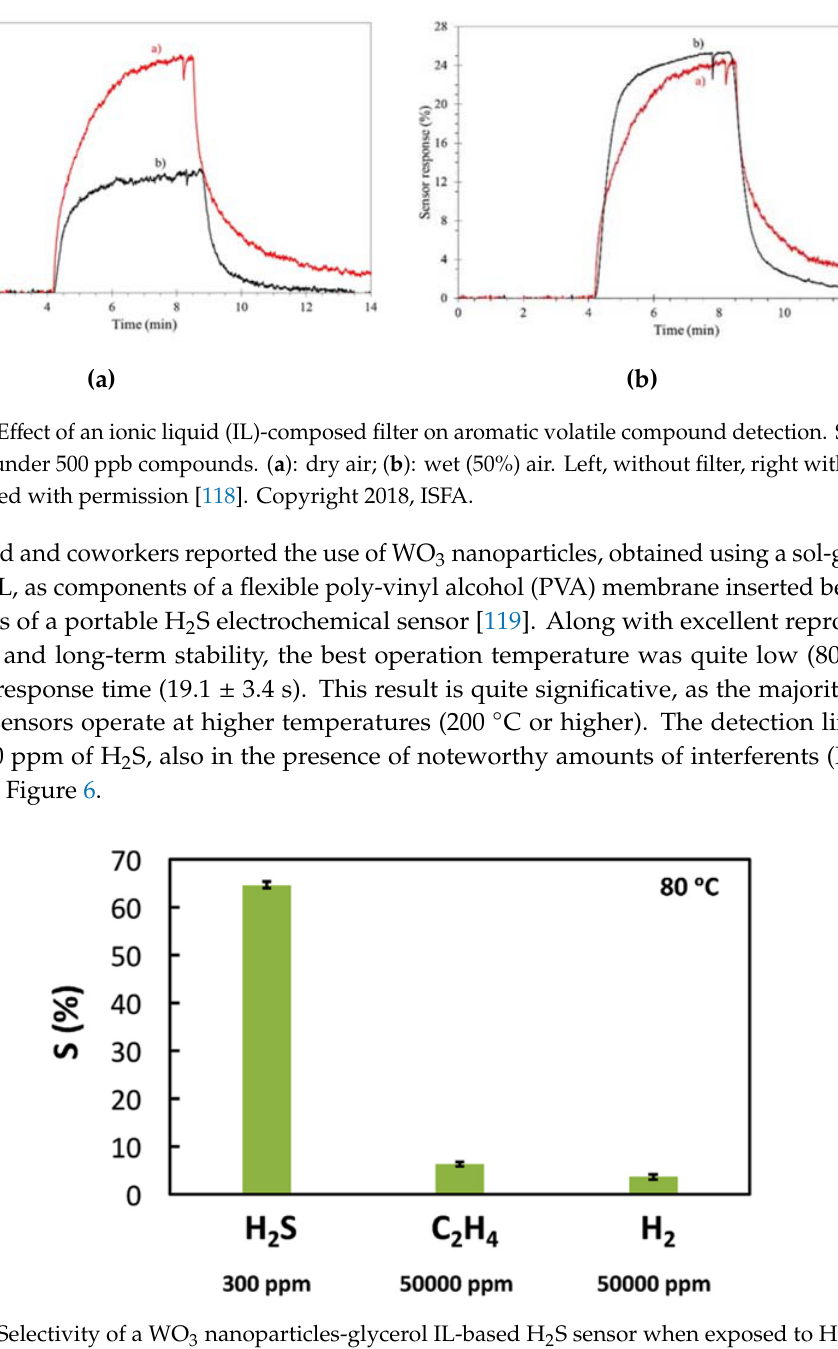
Figure 6. Selectivity of a WO 3 nanoparticles-glycerol IL-based H 2 S sensor when exposed to H 2 S, H 2 and C 2 H 4 at 80 °C. Reproduced with permission [119]. Copyright 2017, Elsevier.